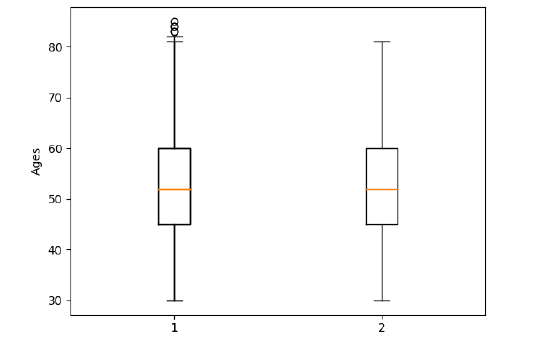
Figure 3. Age Boxplots.